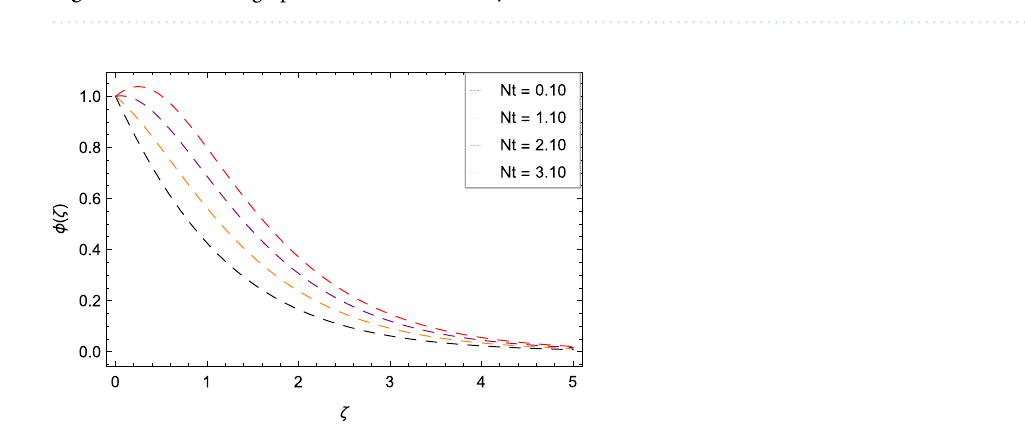
Figure 17. Pattern of graph curves on account of γ 4 .